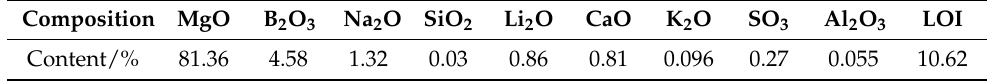
Table 1. The elemental composition of the magnesium residues.